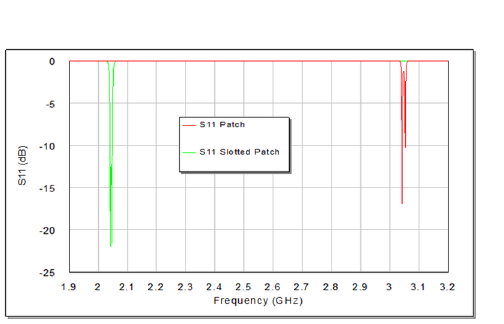
Fig 10. The transmission responses of the two filters; with and without fractal slot.